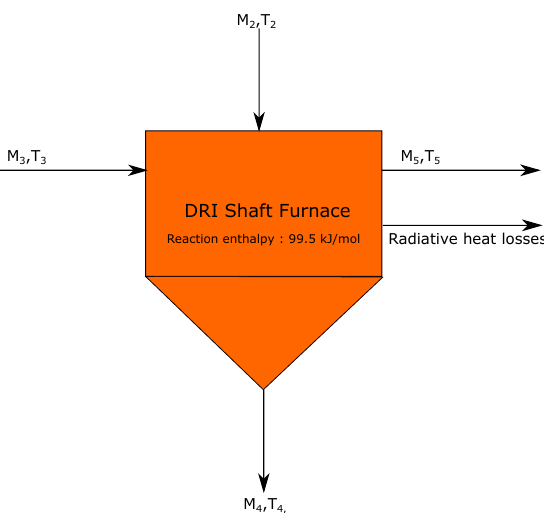
Figure 4. Mass and energy flow through the DRI shaft